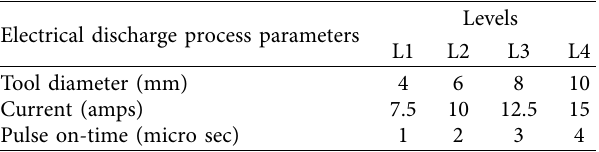
4 C nanocomposites. Table 1: Electrical discharge machining process parameters and their